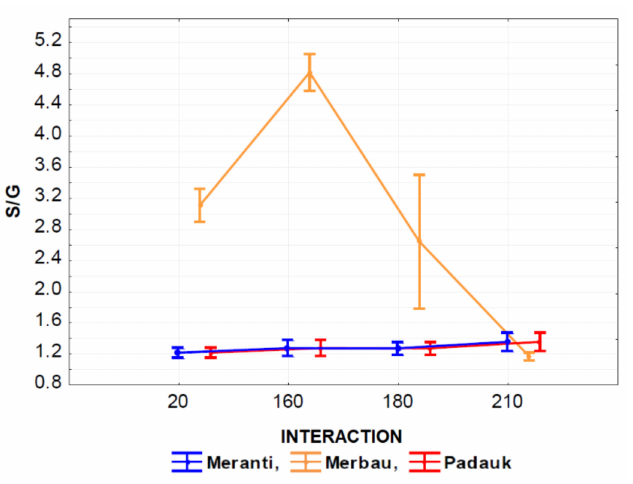
Figure 11. The effect of thermal modification temperature and wood species on syringyl to guaiacyl ratio (S/G)